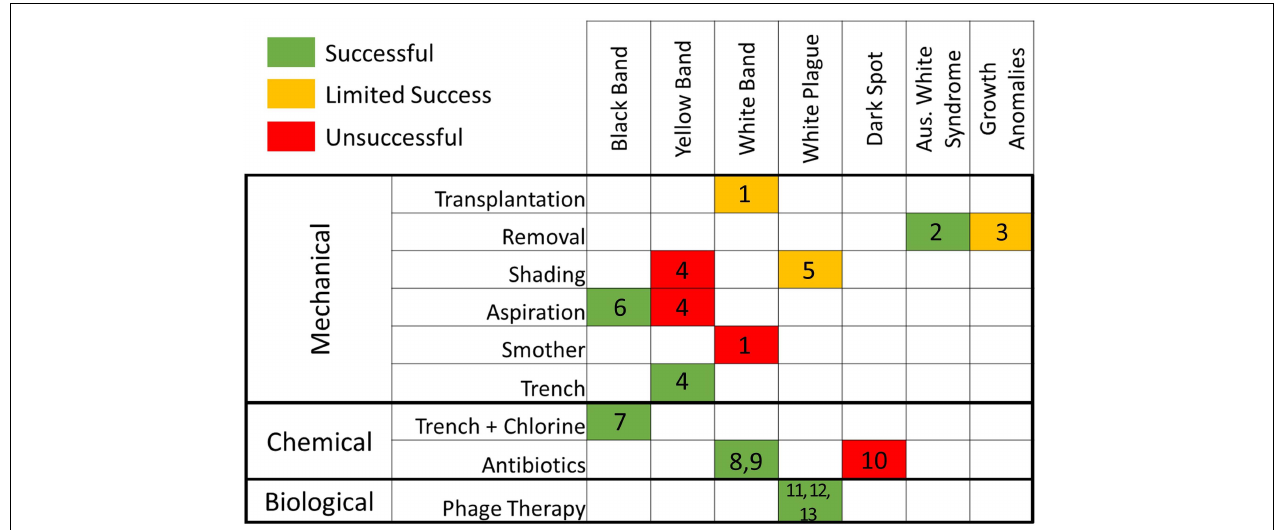
FIGURE 1 | Effectiveness of treatments on corals afflicted with seven diseases, as reviewed from the literature. Effectiveness is color coded as follows: green (effective), yellow (mixed results), red (ineffective). References: 1. Miller et al. (2014); 2. Dalton et al. (2010); 3. Williams (2013); 4. Randall et al. (2018); 5. Muller and Van Woesik (2009); 6. Hudson (2000); 7. Aeby et al. (2015); 8. Sweet et al. (2014); 9. Kline and Vollmer (2011); 10. Gil-Agudelo et al. (2004); 11. Efrony et al. (2007); 12. Efrony et al. (2009); 13. Atad et al. (2012).